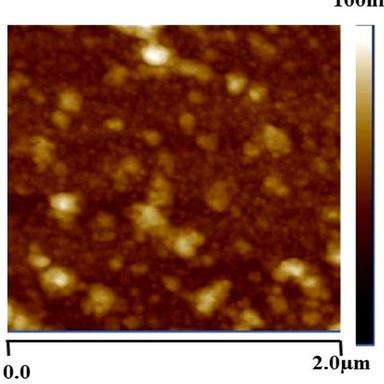
2D AFM image of CZSe thin films.